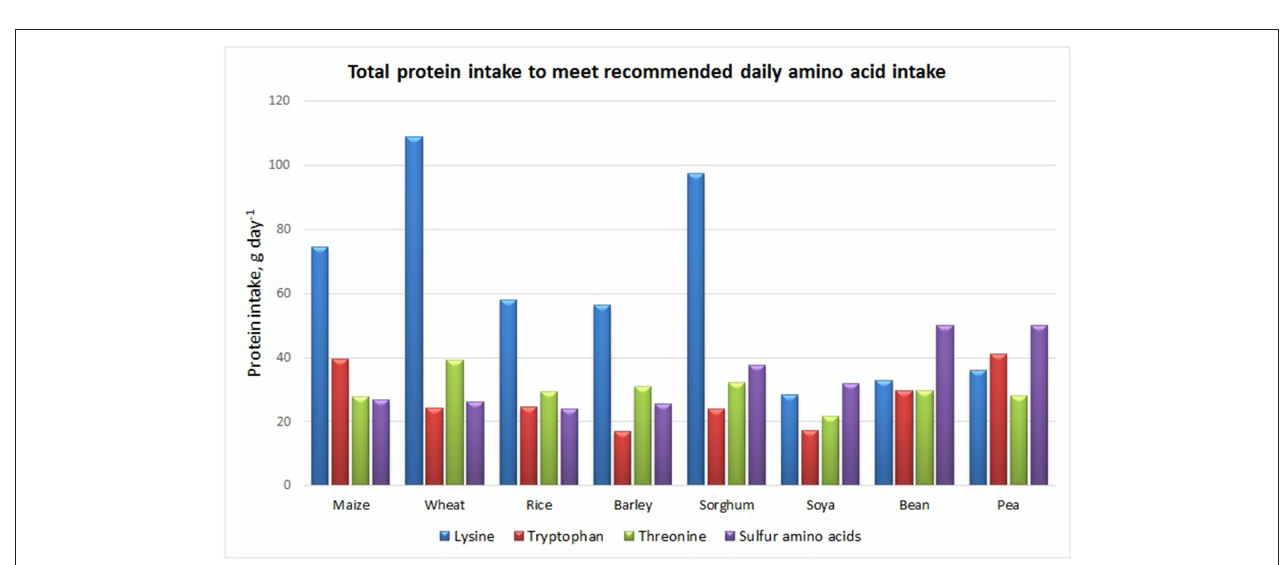
FIGURE 1 | Global production of potentially human edible plant-based protein, showing the most important protein crops.